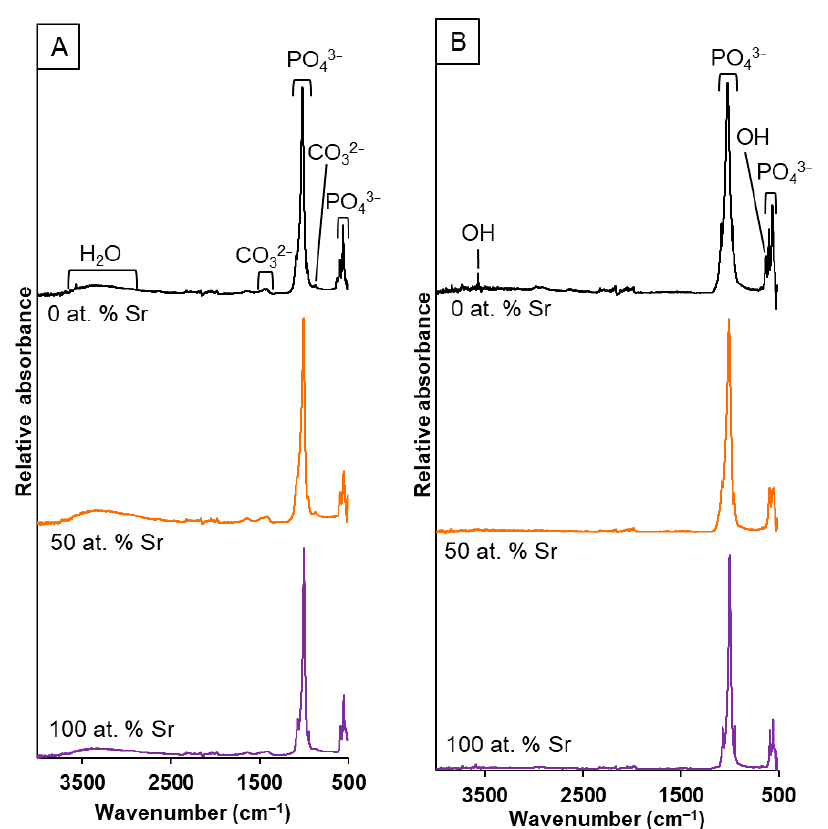
Figure 4. FTIR-ATR spectra of SrHA powders (0, 50 and 100 at.% Sr) produced using the wet precipitation method: unsintered ( A ) and sintered at 1000 °C ( B ).